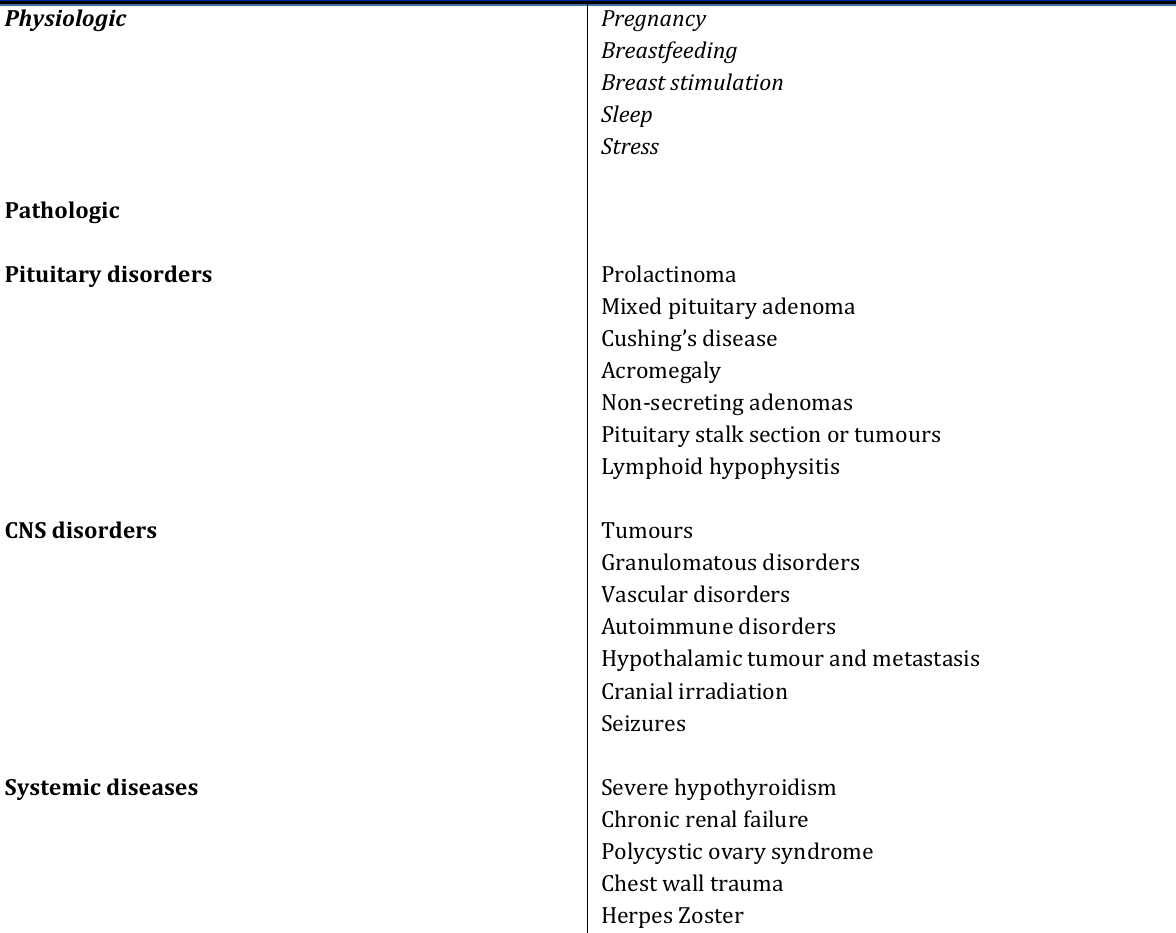
Table 1. Major physiologic and pathologic causes of